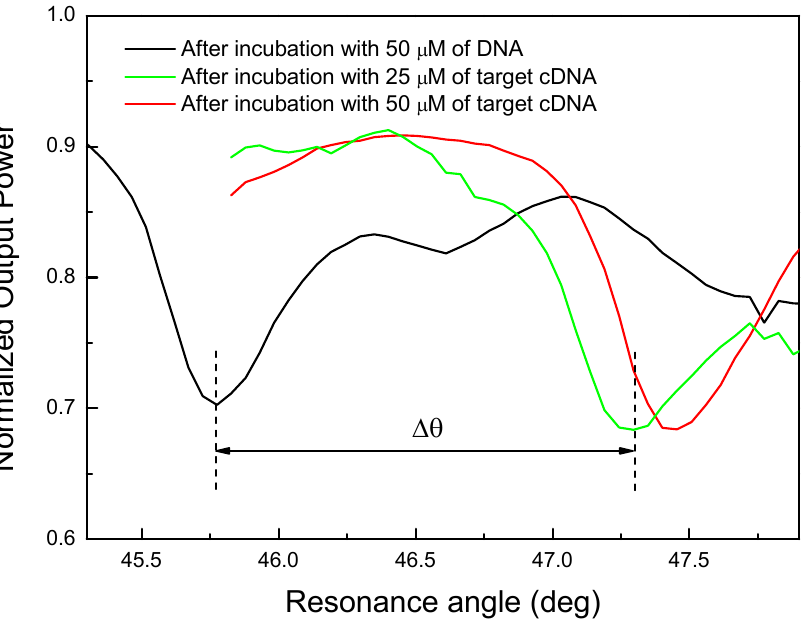
Figure 5. PSi RM resonances after functionalization with probe DNA and after two DNA hybridization steps: the coupling angle shifts demonstrate the molecular interaction between the probe DNA and its complementary target at different